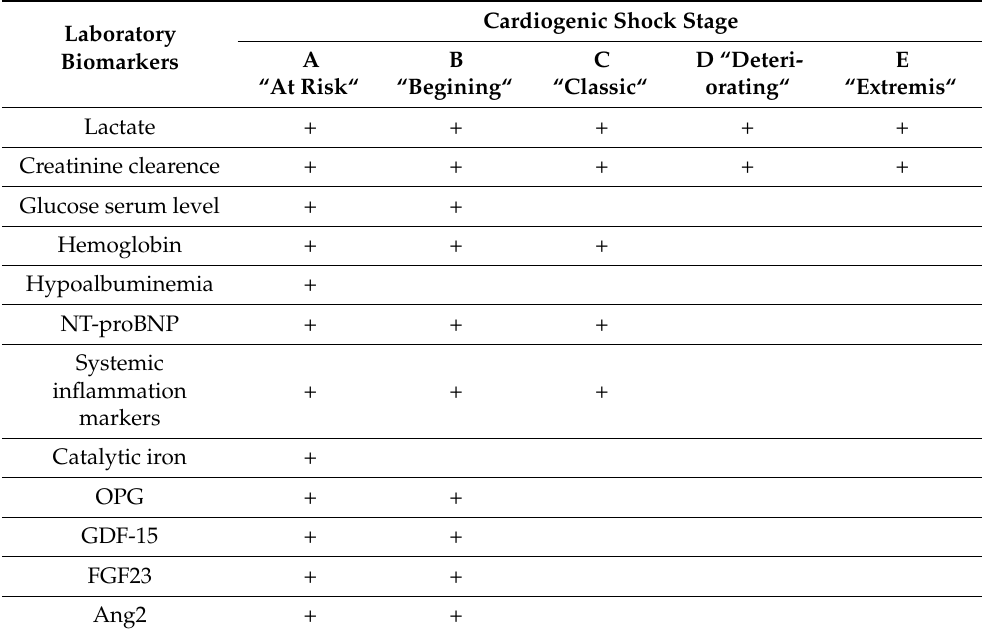
Table 5. Proposes timing of biomarkers detection through the stages of cardiogenic